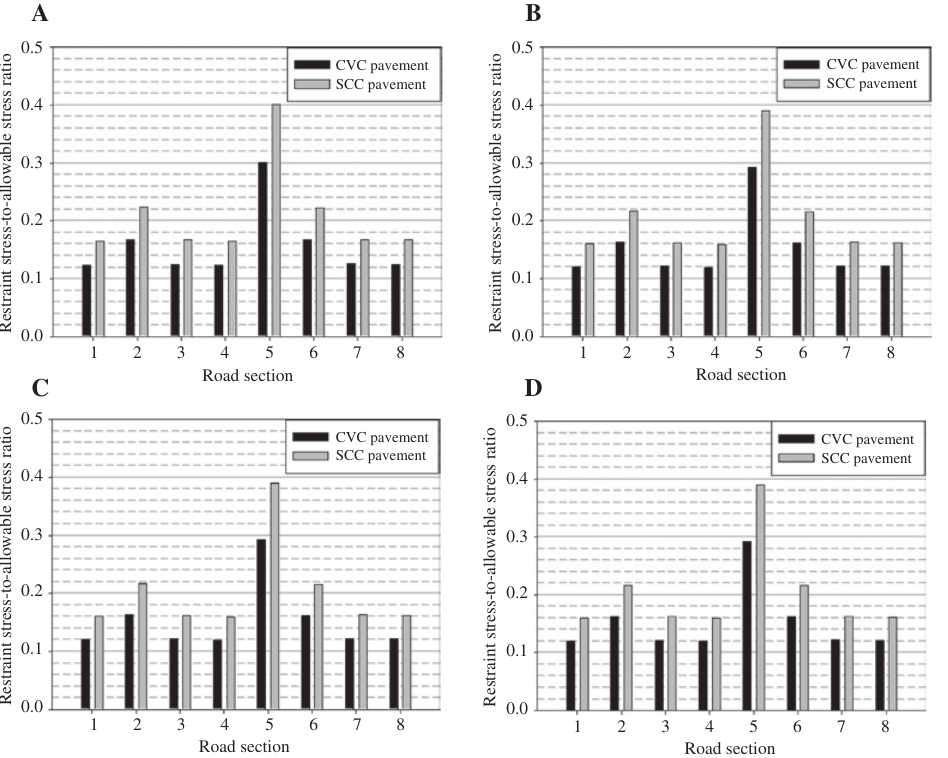
Figure 2: Restraint-to-allowable stress ratios of the CRCP sections in the presence of M13 bars. (A) Grade 10 concrete. (B) Grade 20 concrete. (C) Grade 30 and 40 concrete. (D) Grade 50 and 60